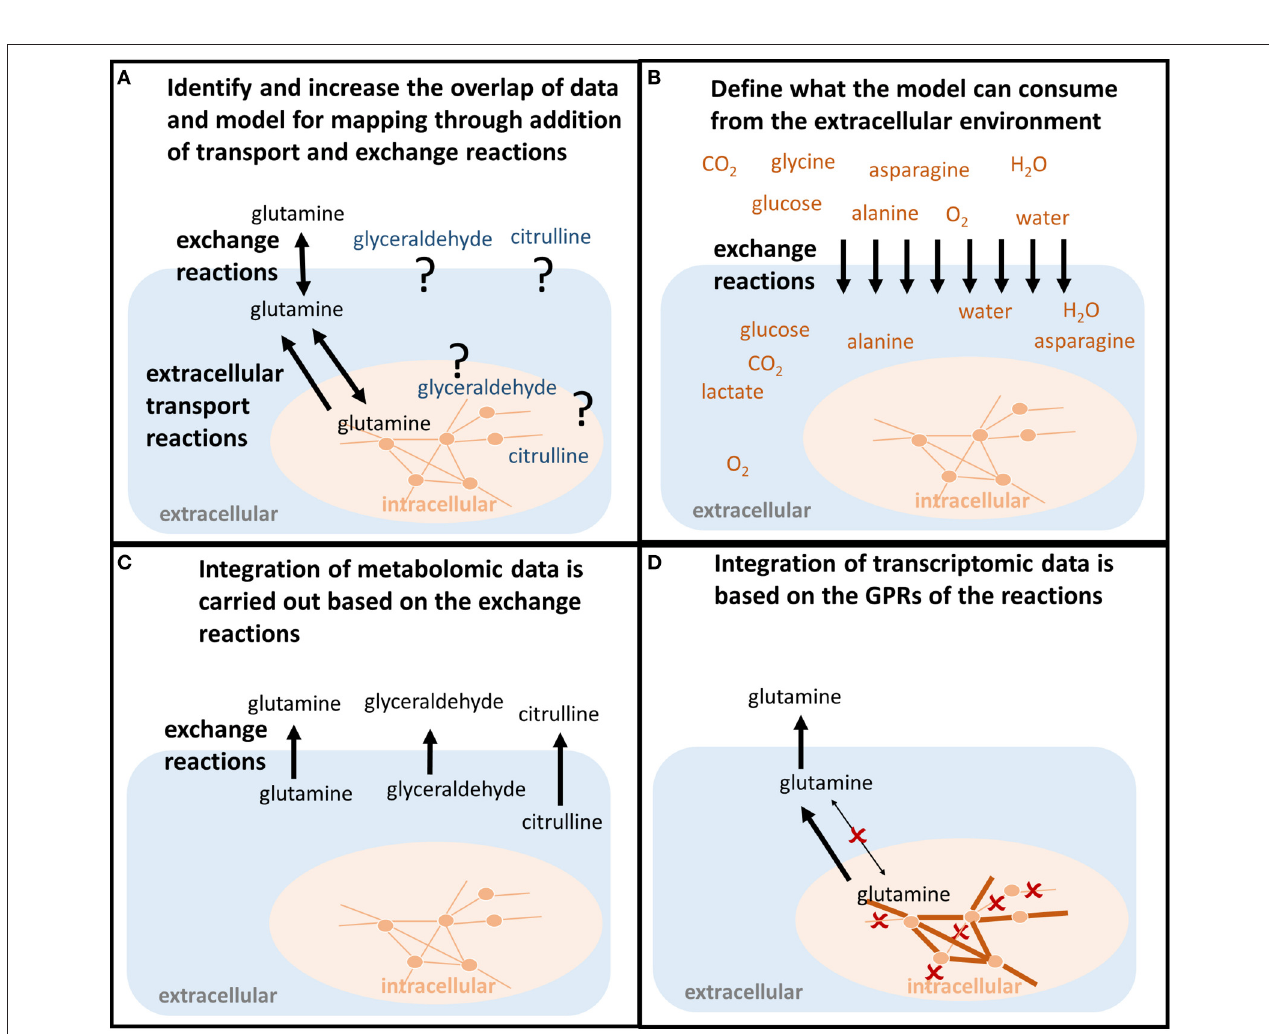
FIGURE 3 | Shaping the model to predict condition-specific metabolic states (contextualized model). (A) In order for the model to follow the measured metabolite uptake and secretion profile, both exchange reactions and transport reactions need to be present to force the metabolite into (uptake) and out of the model (secretion). If those do not exist in the model, the transporters along with the mechanisms need to be identified in order to allow the model to follow the uptake and secretion profile of the experimental data. (B) The uptake of metabolites is constrained based on the concentrations of metabolites available to the conditions that should be investigated. For example, the composition of defined experimental medium can be used. Also, the maximum uptake per cell and time unit can be calculated from the concentrations of nutrients, the concentration of cells, the cell weight, and the duration of the experiment. Otherwise, those constraints would be infinite and relative differences in the metabolite uptake would be less bound to the actual environmental conditions one wants to investigate. (C) Metabolomic data are mapped as constraints to the exchange reactions. Glutamine, glyceraldehyde, and citrulline have to be secreted by the model. (D) Transcriptomic or proteomic data are mapped to the internal network reactions (qualitatively), restricting which reactions a cell can use to transport and metabolize the metabolites, e.g., the enforced secretion of glutamine.